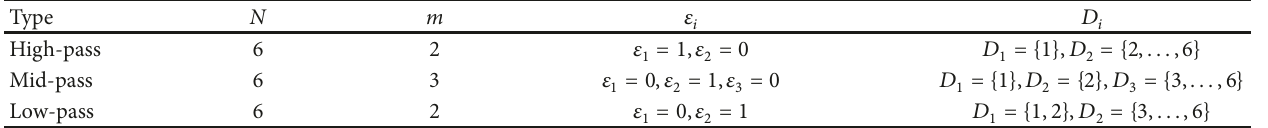
Figure 5: Demonstration of the choice in removing IMFs. (a) Reference dip filtered data by f-x filter, (b) correlation coefficients of different IMFs. Table 1: Comparison of the SNR before and after applying the proposed